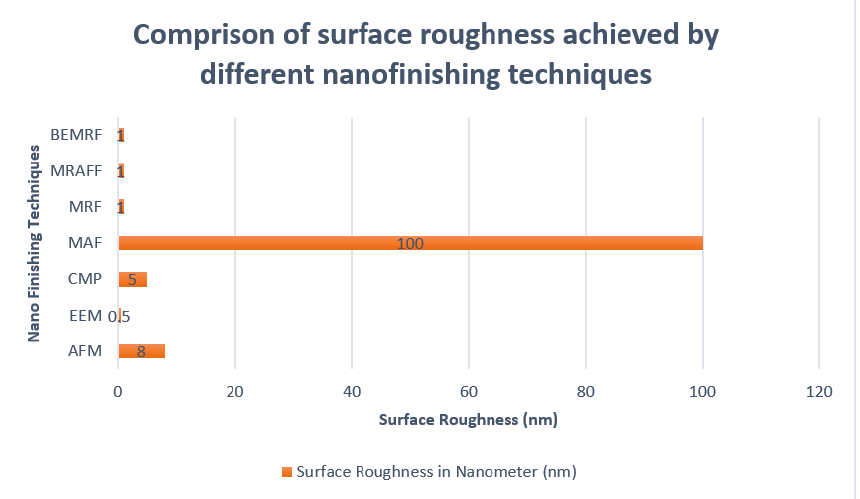
Figure 5. Surface roughness range comparison for nano finishing processes.